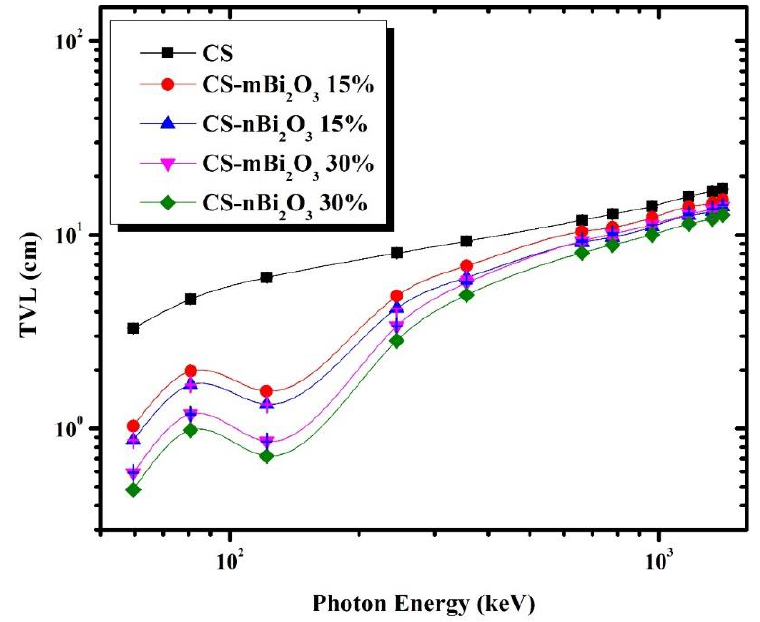
Figure 6. Tenth value layer (TVL) for the prepared mortars as a function of photon energy.